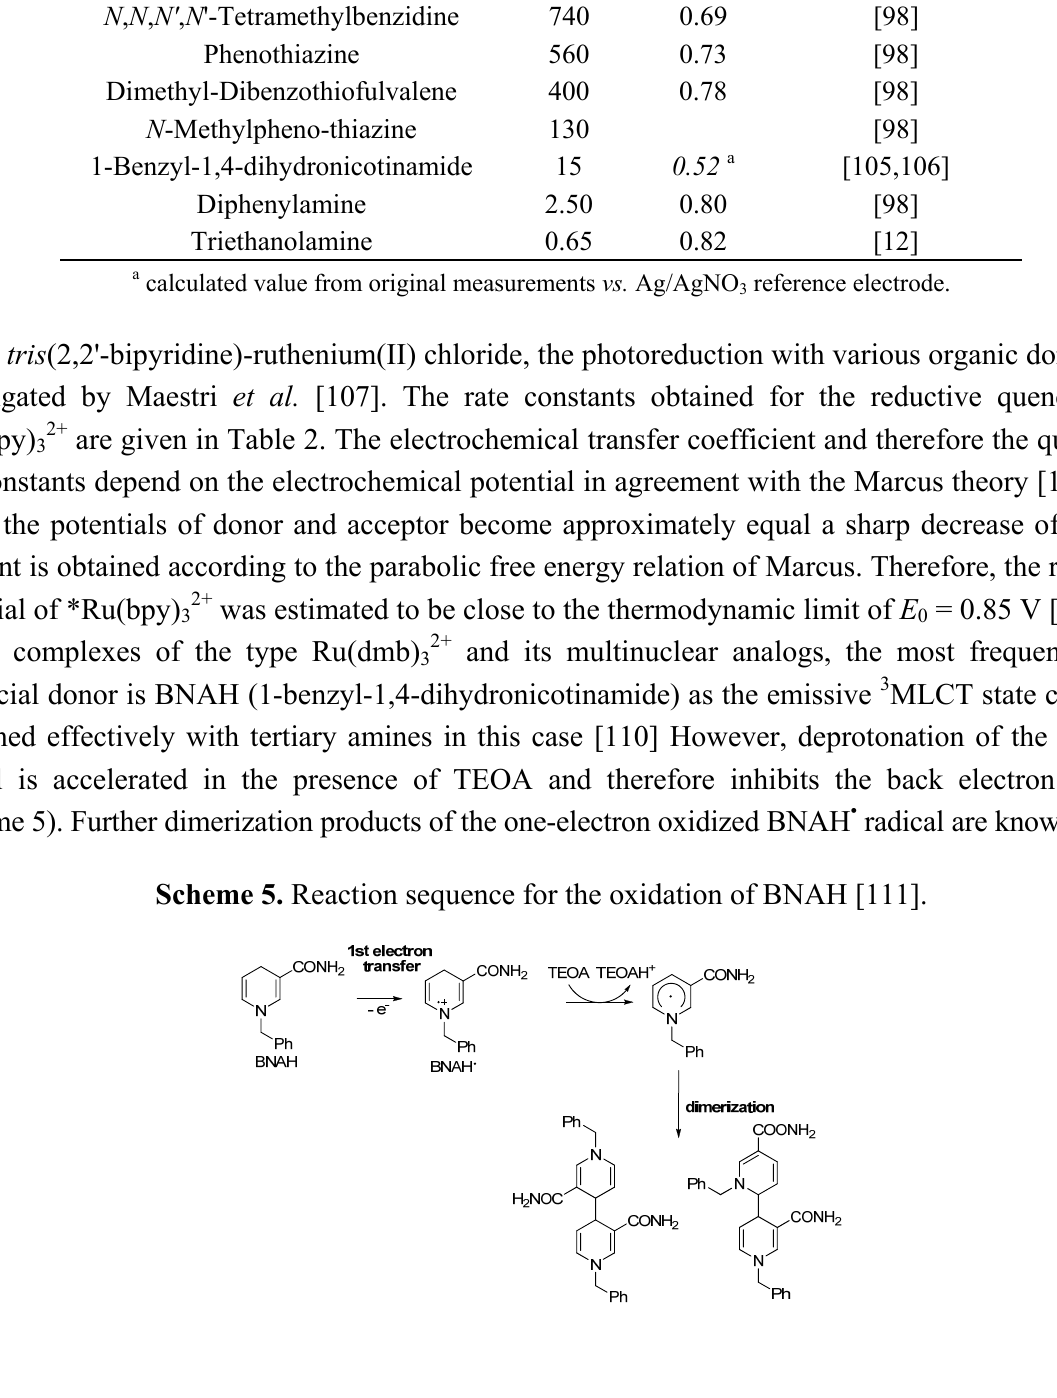
Table 2. Properties of various organic donors in face of reductive quenching of Ru(bpy) 32+ .